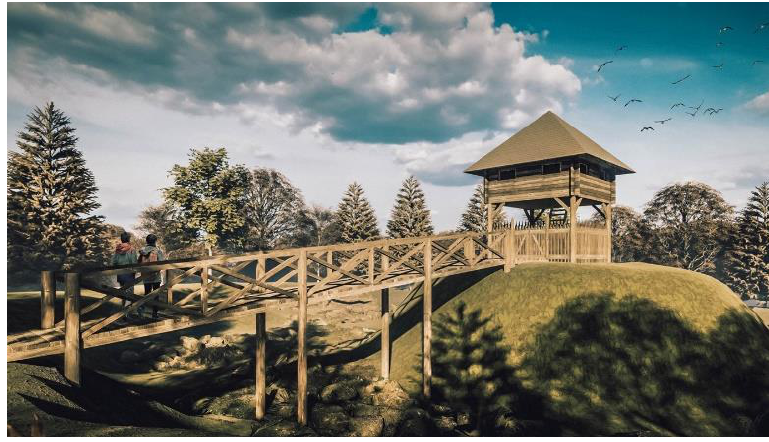
Figure 9. The 3D visualization of the watchtower [70].